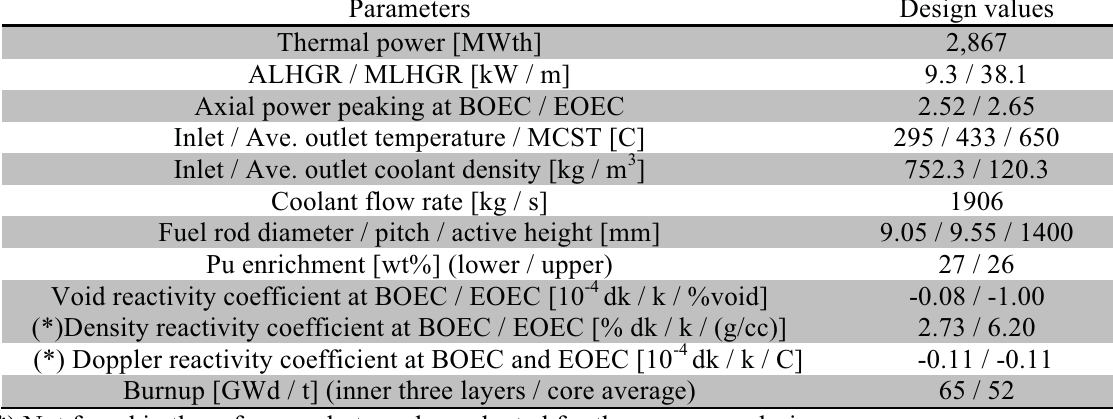
Table I: The reference core design specifications and characteristics